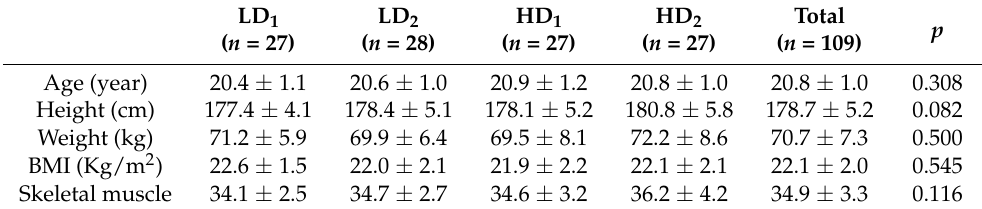
Table 1. The characteristics of